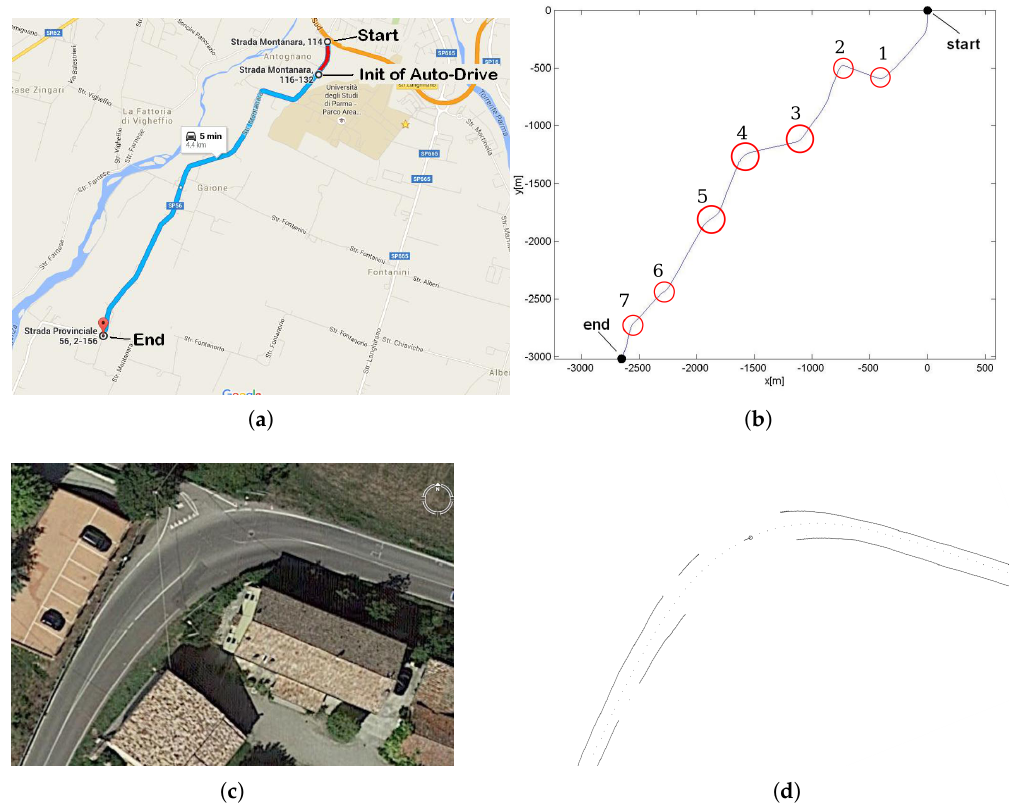
Figure 32. The chosen road section to the autonomous driving tests: ( a ) map from Google Maps; ( b ) map built by the vehicle’s dead reckoning system; ( c ) sky view of curve 2; ( d ) lane markings detected by the vehicle’s vision system in curve